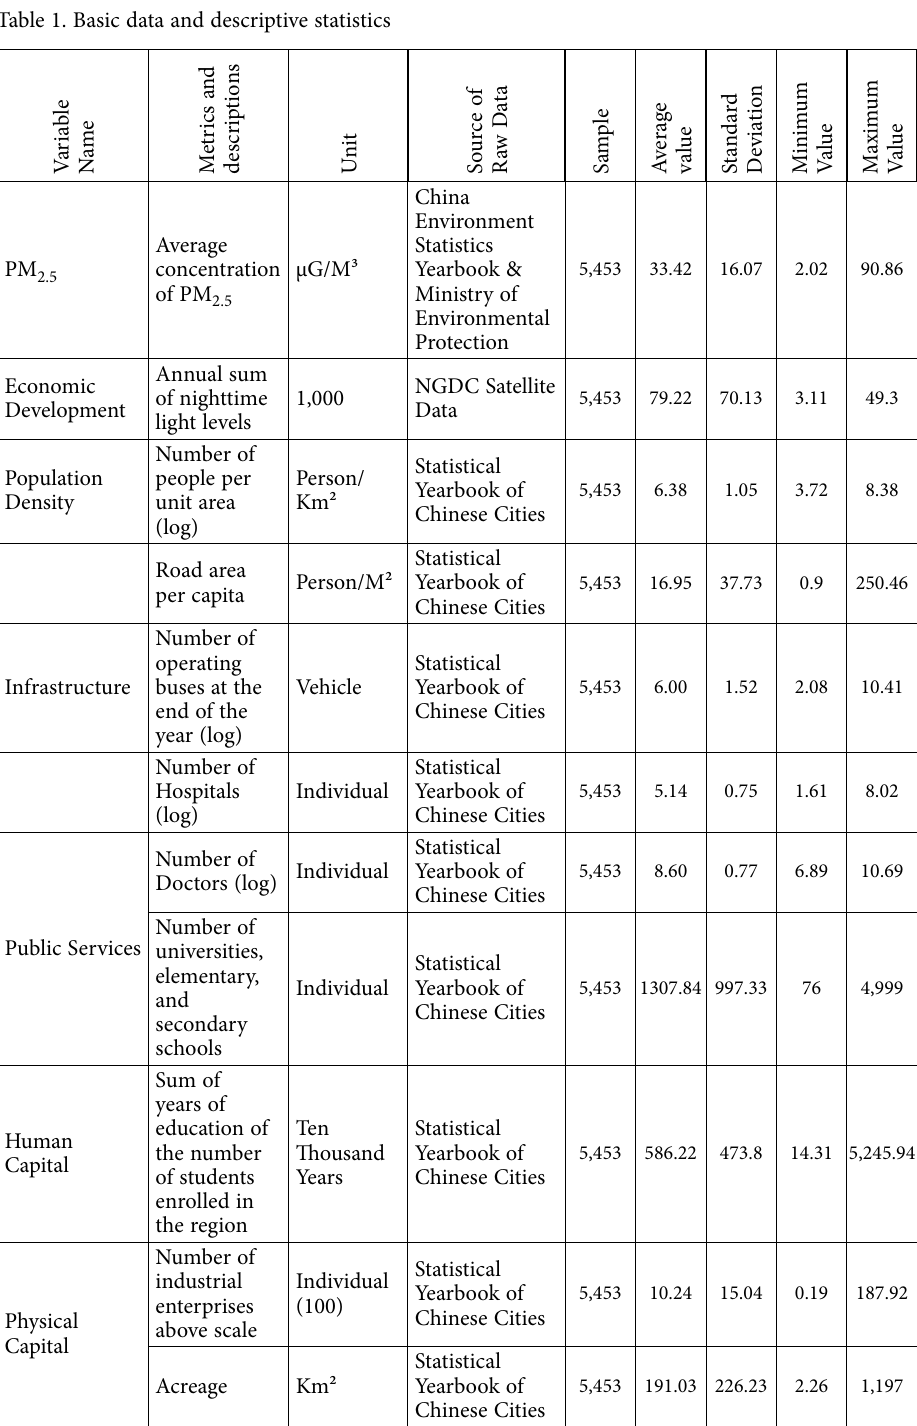
Table 1. Basic data and descriptive